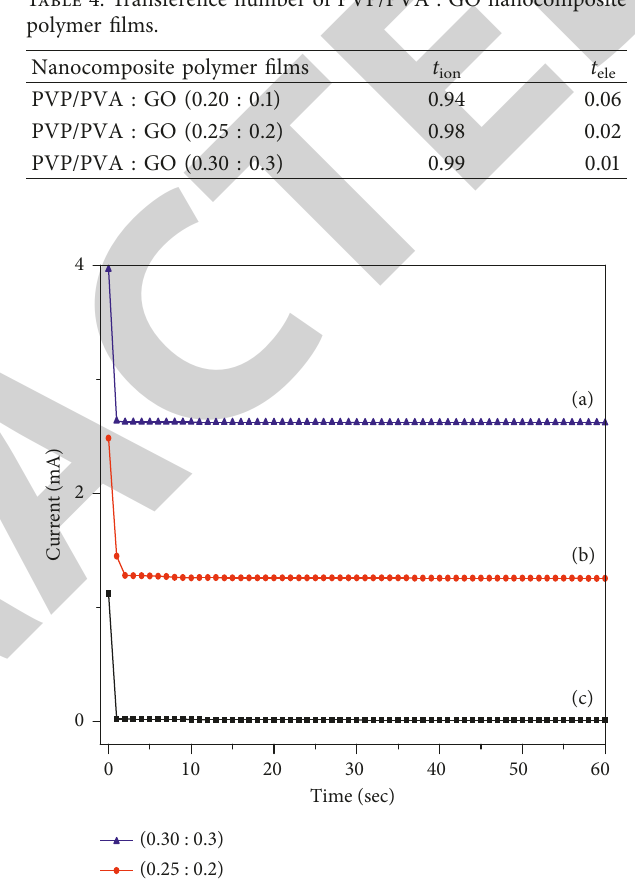
Table 4: Transference number of PVP/PVA : GO nanocomposite polymer films.